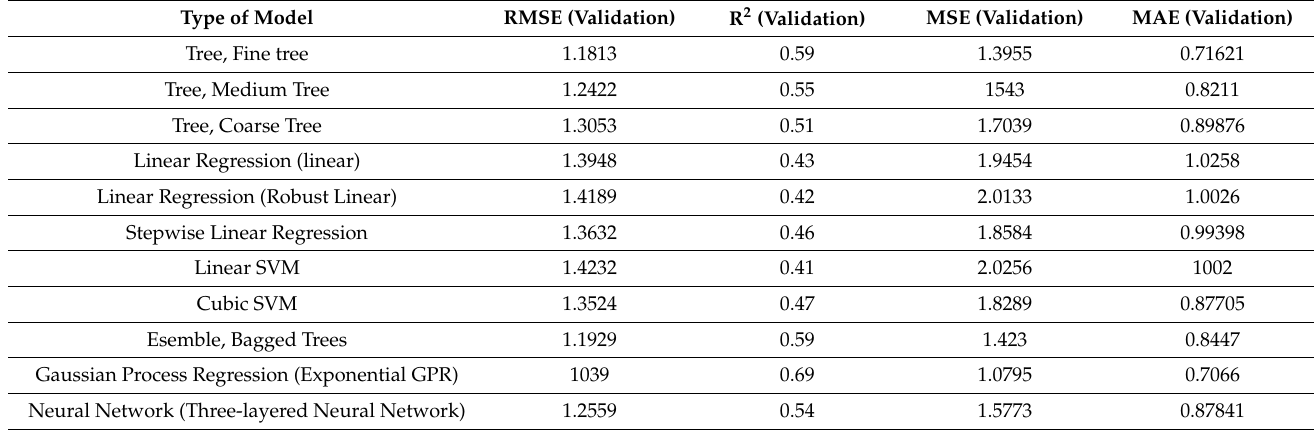
Table 3. Result of emission modeling with different machine learning techniques.